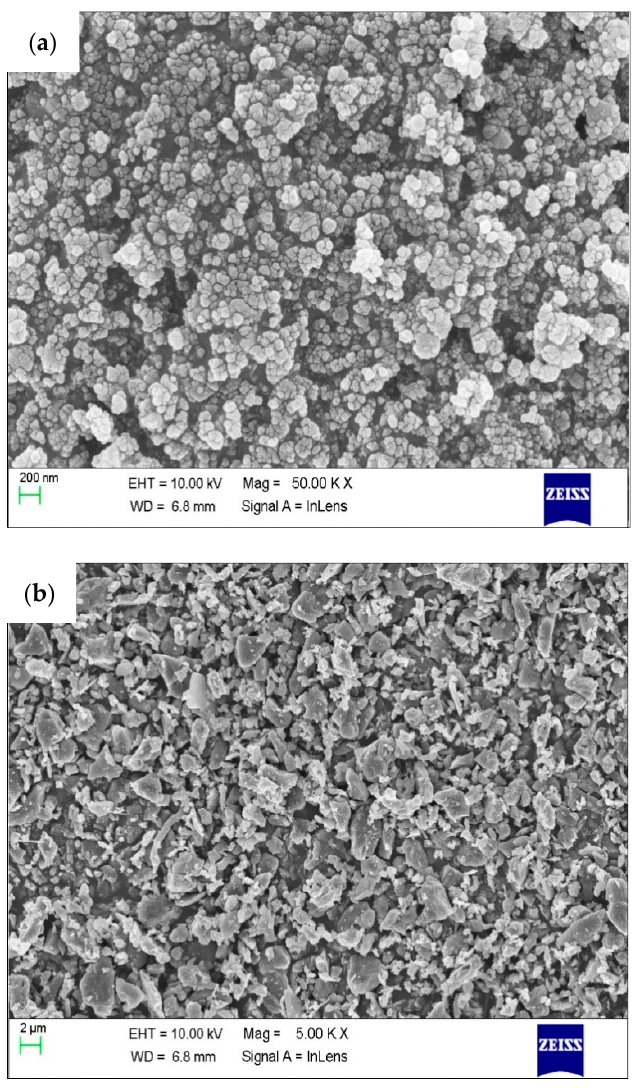
Figure 1. FESEM image of the as-received particles: ( a ) nano-SiC, and ( b ) micro-SiC. Table 2. Characteristics of the FSSW